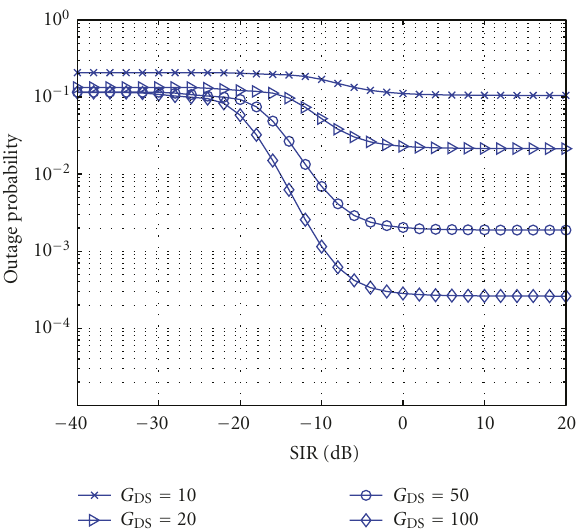
Figure 10: Outage probability of a DS/FH system, impact of processing gain, the number of antenna elements M = 2, the number of users K = 40, the number interferers are J 1 = 1, J 2 = 2, J 3 = 3, duty cycles of interferes are ρ 1 = ρ 2 = ρ 3 = 0 . 2, SNR Γ N = 100 dB, the number of hopping channels N = 10, the number of multiple path L = 3, decay factor δ = 0, and protection ratio r th = 3dB.